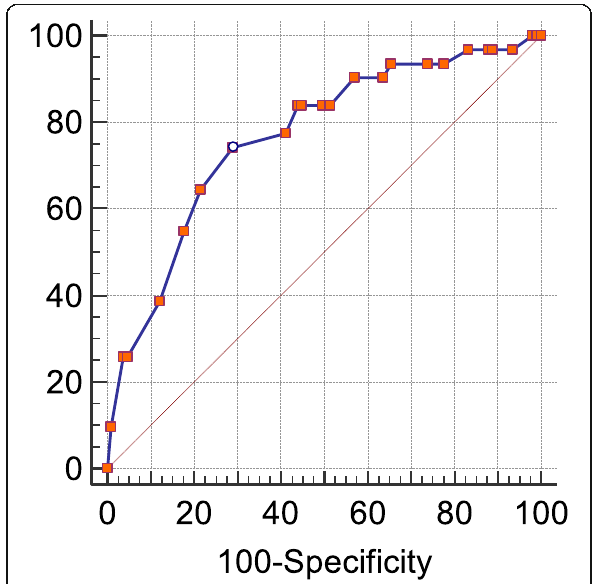
Fig. 4 Receiver operator characteristics (ROC) analysis showed that vitamin D serum level − 17 ng/ml that best predict stroke outcome (as determined by mRS score) with sensitivity and specificity of 81.4% and 42.7%, respectively. Area under curve (AUC) was 65.4% was significantly different from the random 50% ( p <